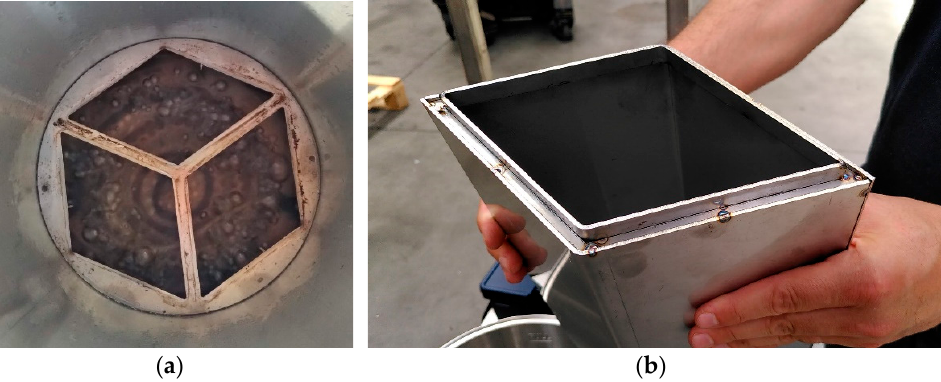
Figure 3. Further details of bioreactor assembly; ( a ) Internal airflow through the bottom water bath; ( b ) Bottom view of the rhombohedral sector before being assembled to its drilled bottom.